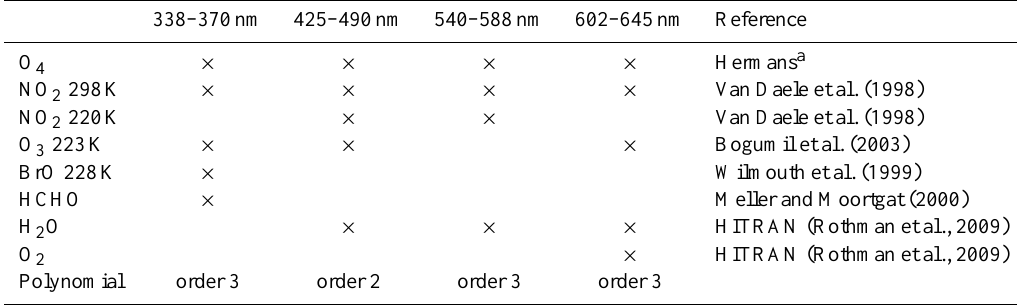
Table 1. DOAS retrieval settings.